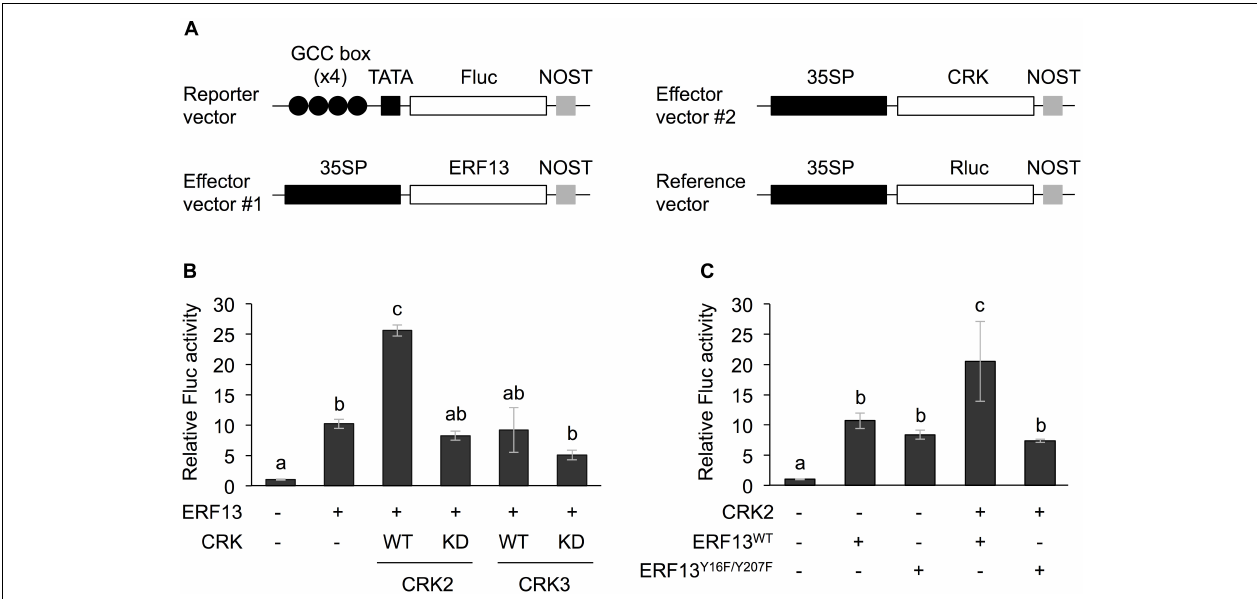
FIGURE 1 | Dual luciferase (LUC) activity mediated through CRK-activated ERF13. (A) Schematic diagram of the reporter and effector vectors used in dual LUC assays. (B) Four inverted repeats of GCC-box fused to a minimal TATA-box and a firefly LUC (Fluc) reporter gene. Transient activation of the reporter gene according to co-expression with (+) or without (-) ERF13, wild-type (WT) and kinase dead-mutant (KD) of CRK2 or CRK3 in Arabidopsis protoplasts was assessed. (C) Likewise, transient activation of the reporter gene according to co-expressed effector(s), CRK2, WT of ERF13 (ERF13 WT ), or ERF13 mutant deficient in CRK-phosphorylated sites (ERF13 Y16F / Y207F ) in Arabidopsis protoplast cells was assessed. Data represent the mean and standard error ( n = 3). Renilla luciferase (Rluc) activity was used to normalize for the efficiency of transformation. Means indicated by different small letters are significantly different, based on a one-way ANOVA with post hoc Tukey’s HSD ( P < 0.05). NOST, nopaline synthase terminator; 35SP, cauliflower mosaic virus 35S promoter; and TATA,